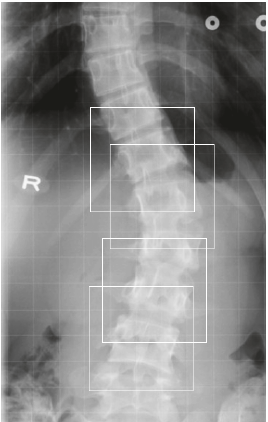
Figure 3: Vertebral patches assigned by a